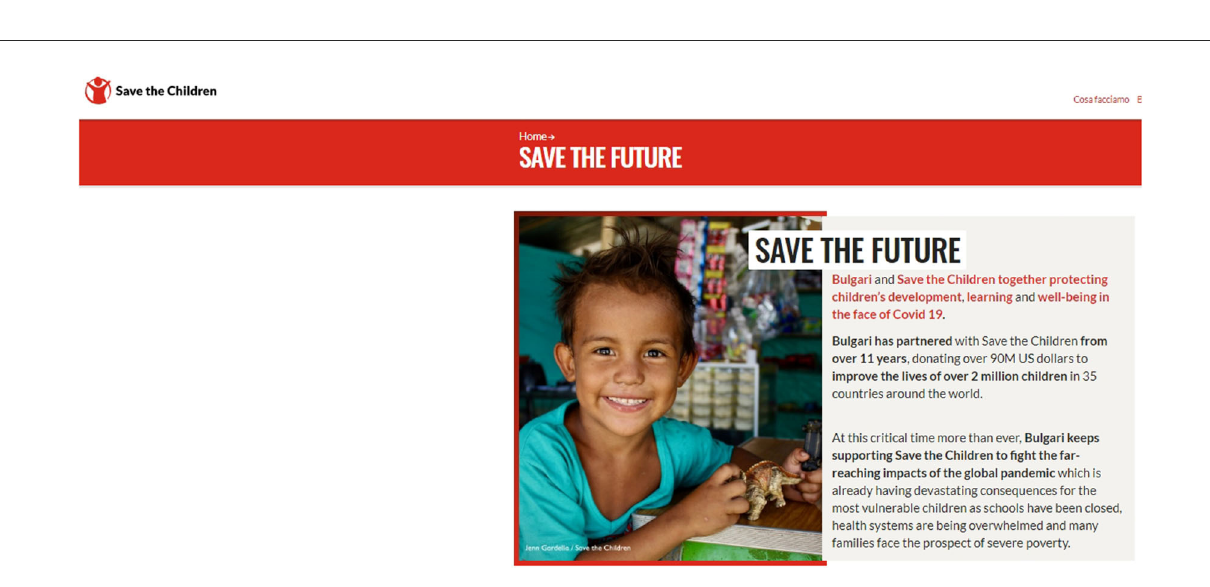
FIGURE2 UNICEF’s website addresses the fight against COVID-19 in disadvantaged areas.